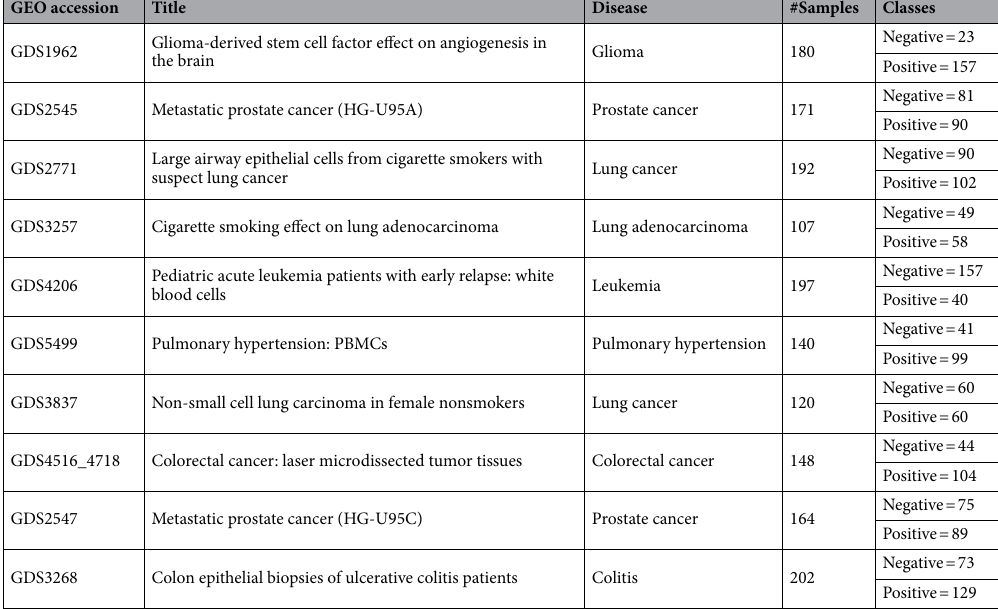
Table 1. Description of the 10 datasets used in the study. Each entry has the GEO accession, the name of the disease, the number of samples and the data classes.